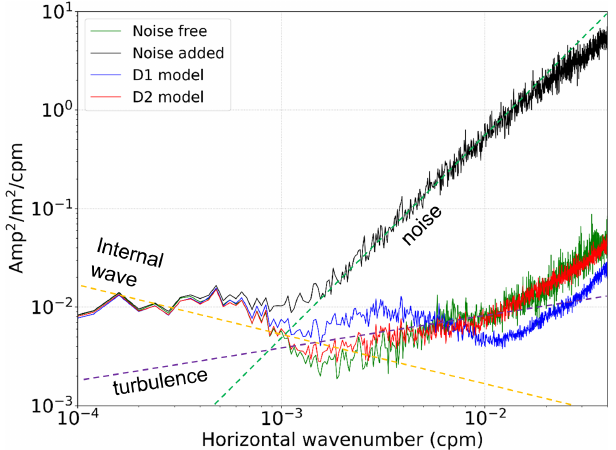
Figure 17. Data slope spectra of noise-free (green) and noise-added (black) synthetic seismic sections and noise-attenuated synthetic seismic section using the D1 model (blue) and D2 model